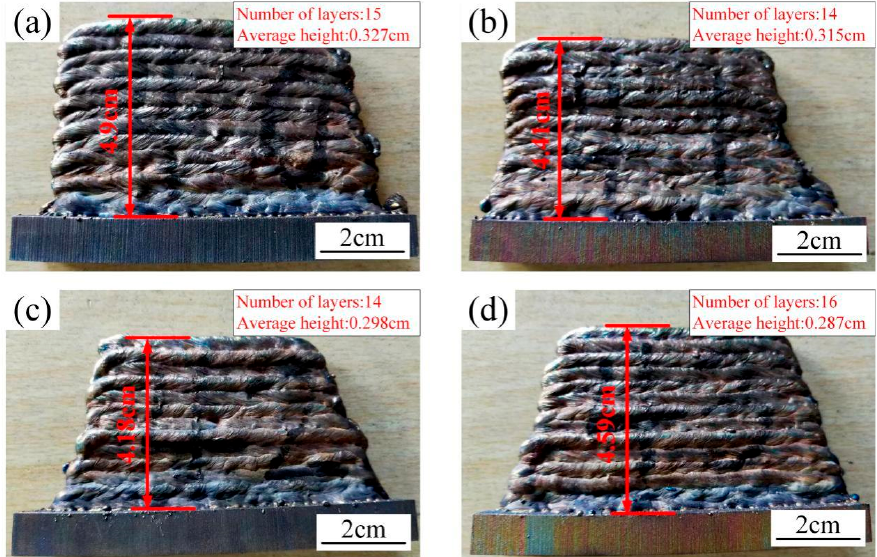
Figure 5. Macro forming of titanium alloy DED-AAM component with the wire feeding speed of 7 m/min: ( a ) I M = 0 A, ( b ) I M = 1 A, ( c ) I M = 2 A, ( d ) I M = 3 A.